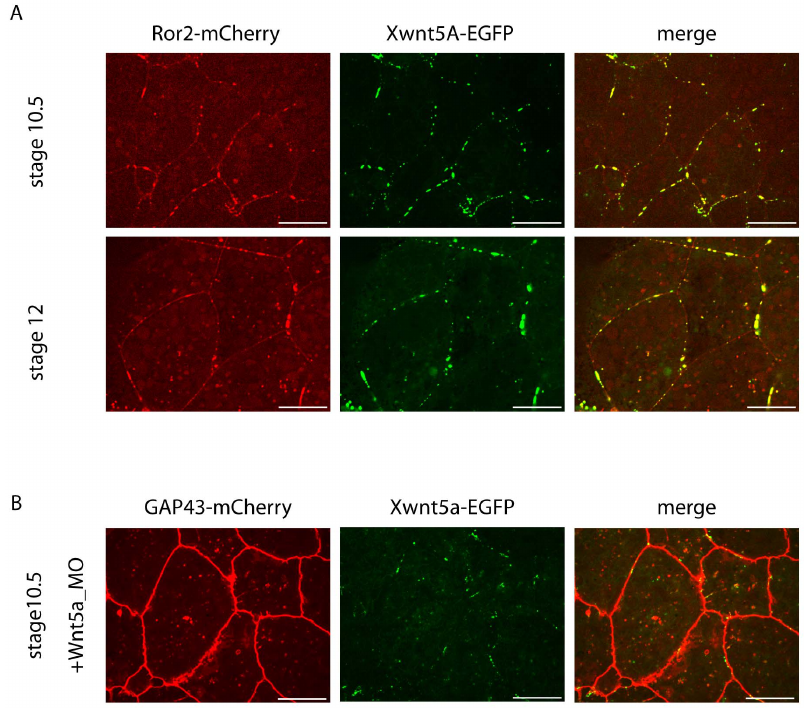
Figure 5. Xwnt5A induces clustering of ROR2. A) 150 pg of Xwnt5A-EGFP mRNA were co-injected with 40 pg of the ROR2-mCherry in the two dorsal blastomeres of eight-cell stage embryos. At stage 10.25 dorsal marginal zones were explanted and analyzed for subcellular localization of the Xwnt5A-EGFP and ROR2-mCherry. Prominent Xwnt5A-EGFP clusters co-localize with ROR2-mCherry clusters at the membrane of DMZ cells. These clusters are found at the onset (stage 10.5) and at the end (stage 12) of gastrulation. Shown are snapshots of movies S5 and S6. B) 150 pg of Xwnt5A- EGFP mRNA were co-injected with 1.6 pmol Xwnt-5A specific antisense morpholino and 125 pg Gap43-mCherry. Also in these Xwnt-5A-depleted explants Xwnt5A-EGFP clustered in the